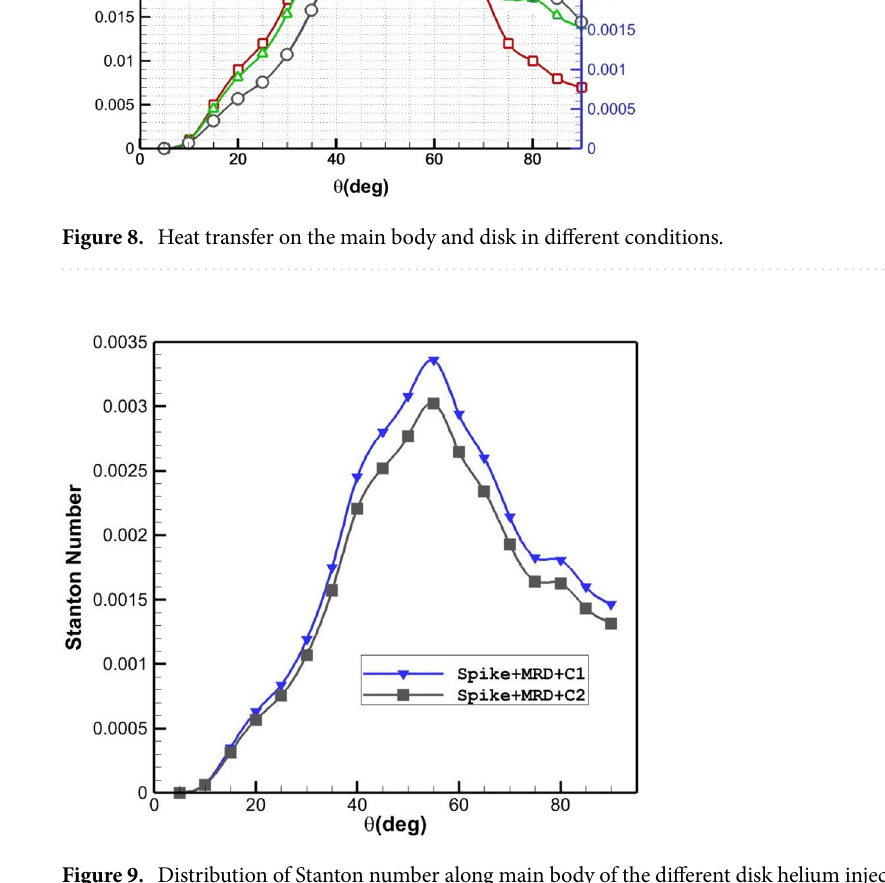
Figure 9. Distribution of Stanton number along main body of the different disk helium injection